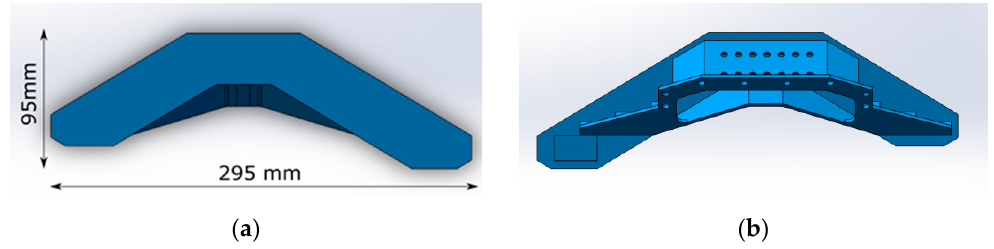
Figure 9. Infrared horizon mirror 3D model: ( a ) mirror machining surface and ( b ) mirror clamping surface.